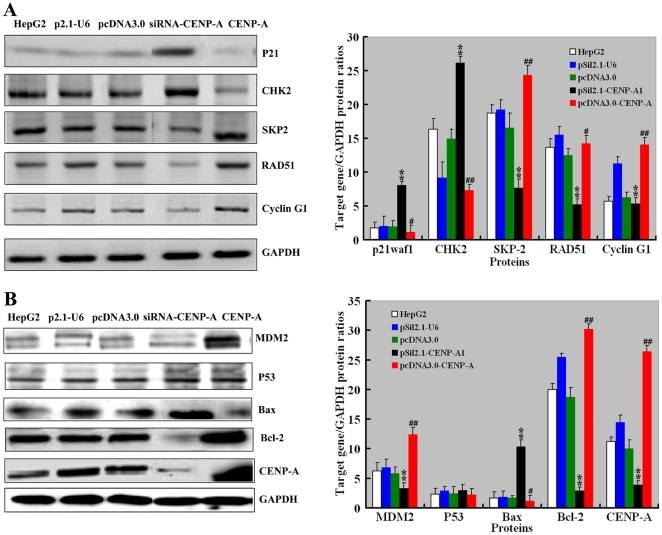
Alteration of gene expression profiling by CENP-A overexpression or knockdown in HepG2 cells.HepG2 cells were untreated or transfected with CENP-A-expressing plasmids, siRNA-expressing plasmids, or empty vectors (pcDNA3.0, and pSil2.1-U6). Forty-eight hours after the transfection, cells were subjected to Western blotting for the proteins indicated. A&B: Representative Western blots are shown in left panels. Right panels show the quantification of the immunoblots. #
P<0.05, ##
P<0.01, compared to the pcDNA3.0 empty vector; **
P<0.01, compared to the pSil2.1-U6; n = 3.